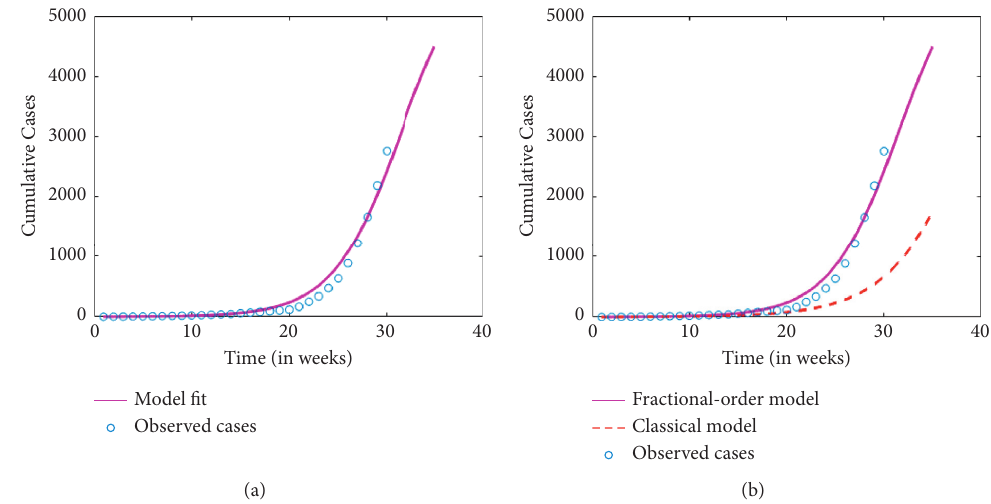
Figure 3: (a) The estimation of the fractional-order model with α � 0 . 937635. (b) Prediction of the fractional-order (with α � 0 . 937635) and integer